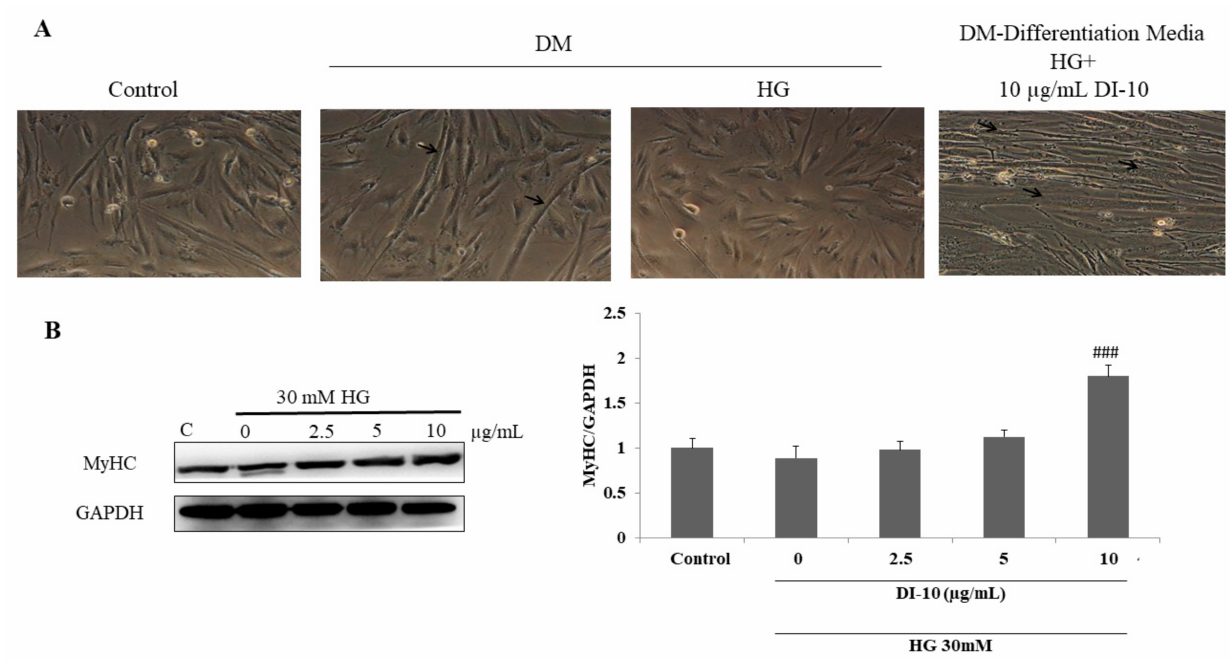
Figure 4. Decapeptide DI-10 promotes myoblast differentiation under high-glucose conditions. Effect of decapeptide DI-10 on myogenic differentiation under hyperglycemic conditions was determined by ( A ) microscopic observation of cell morphology. Photomicrographs were obtained using an Olympus ® CKX53 microscope (100 × ) ( B ) MyHC expression in C2C12 cells under HG conditions. ### p < 0.001 compared to the high